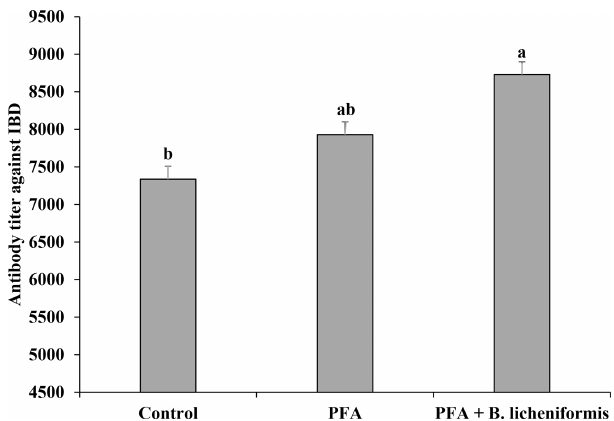
Figure 2. Antibody titer against infectious bursal disease (IBD) in broiler chickens fed supplemental phytogenic feed additive (PFA) alone or in combination with B. licheniformis (PFA + B. licheni- formis ). Broilers fed diets supplemented with PFA in combination with B. licheniformis had greater ( P = 0 . 003) antibody titer against IBD than those fed basal diet only (control group). Different super- scripts among the bars differ